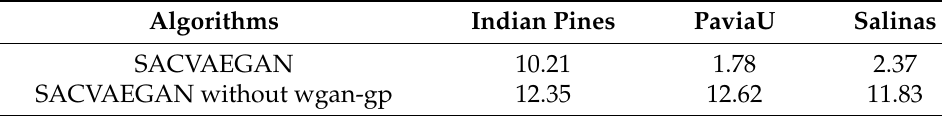
Table 16. FID value of the model with or without WGAN-GP.